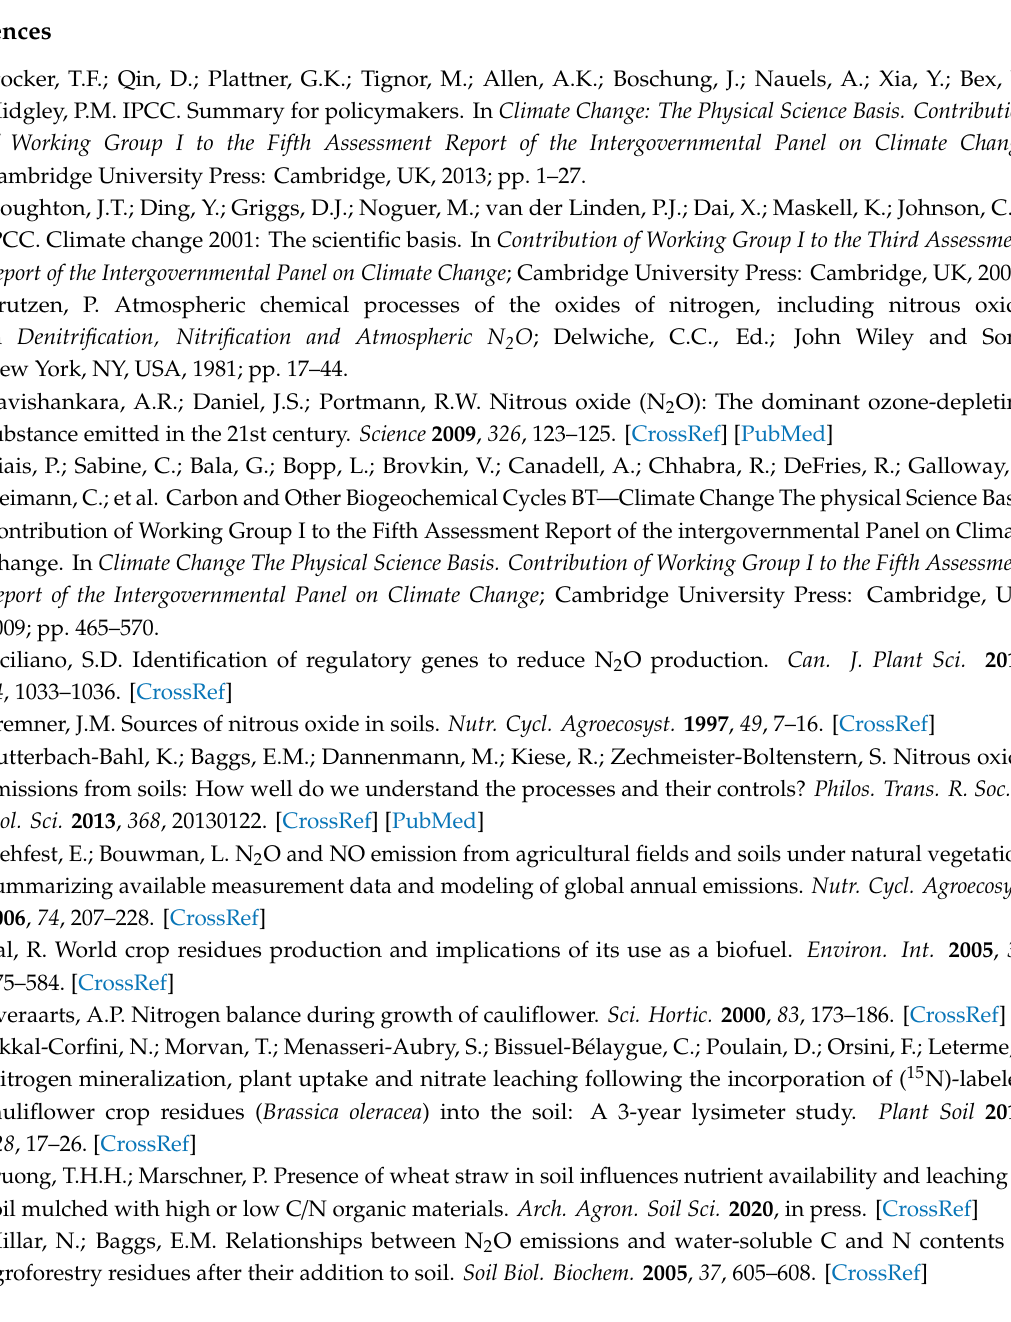
Figure S1: Flow chart for the selection process of the meta-analysis, Figure S2: Funnel plot of e ff ect size distribution around the overall mean e ff ect size, Table S1: Observations used in the meta-analysis with corresponding values and